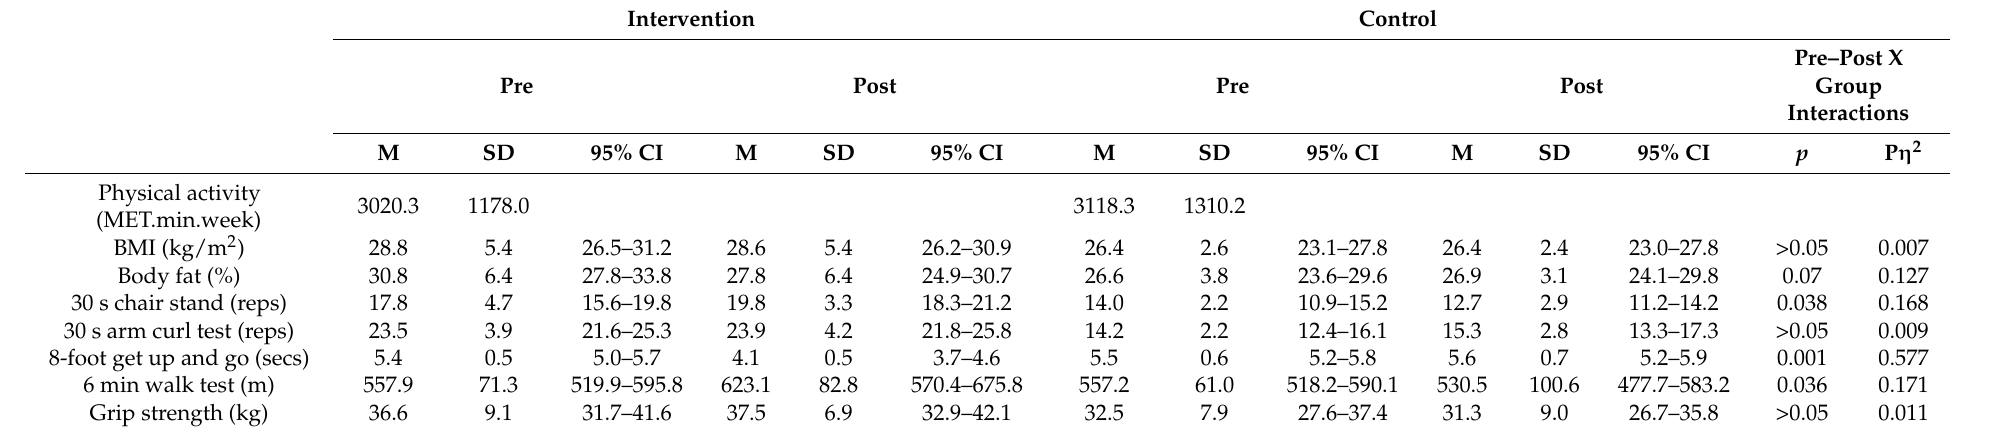
Table 1. Mean (M), standard deviation (SD) and 95% confidence intervals (CIs) for anthropometric and functional fitness variables before and after in recreational football for health intervention group and matched